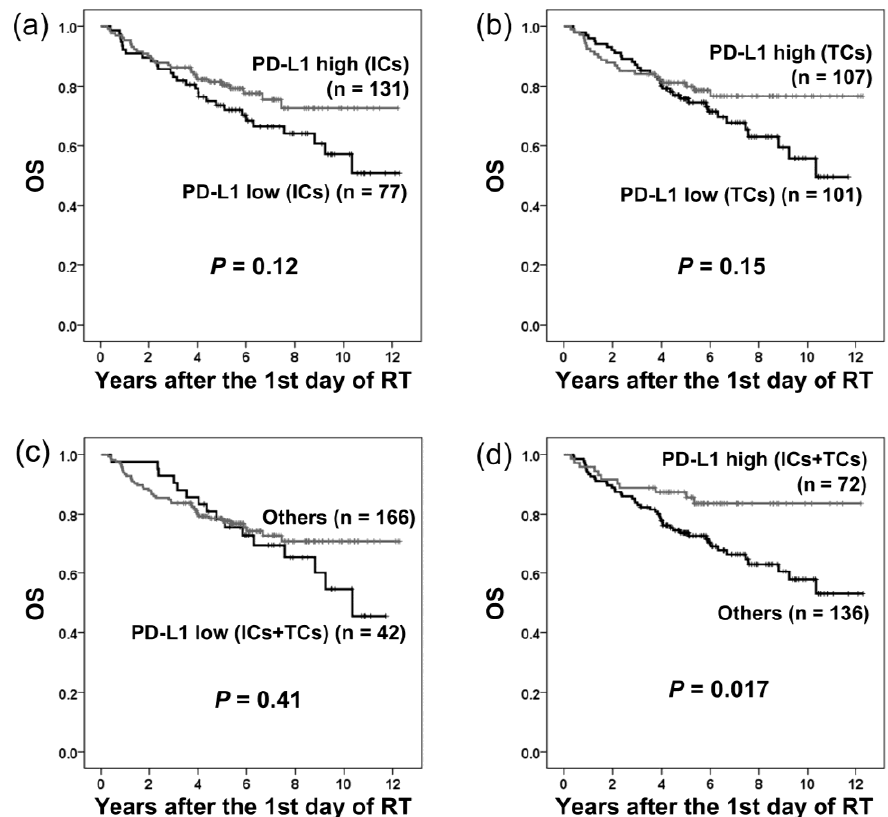
Figure 5. Overall survival (OS) in patients with different levels of PD-L1 expression on immune cells (ICs) and tumor cells (TCs). Low PD-L1 expression on ICs ( a ), TCs ( b ), or both ICs and TCs ( c ) had no significant influence on OS. High PD-L1 expression on both ICs and TCs ( d ) correlated with significantly longer OS.